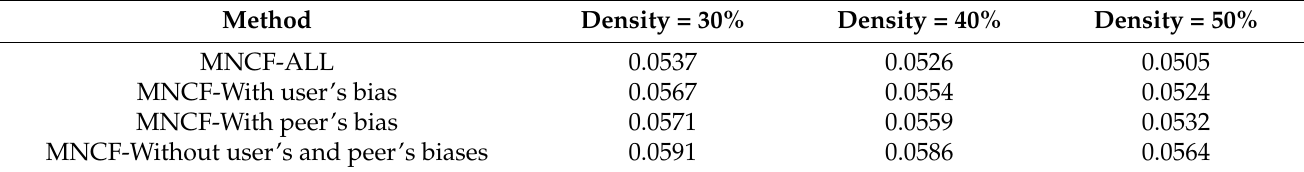
Table 5. Performance of RMSE with Different Contexts (MaxBlockBack = 12, MaxRTT = 1000).